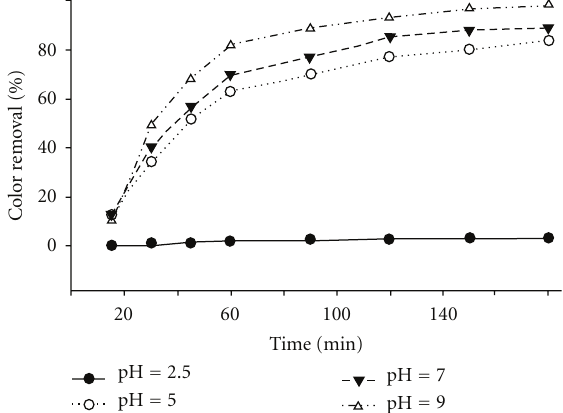
Figure 9: The e ff ects of temperature on the photodegradation methyl green [methyl green] 0 = 40mg L − 1 , [Fe-OP-NCY] = 1gL − 1 , pH = 5.2.